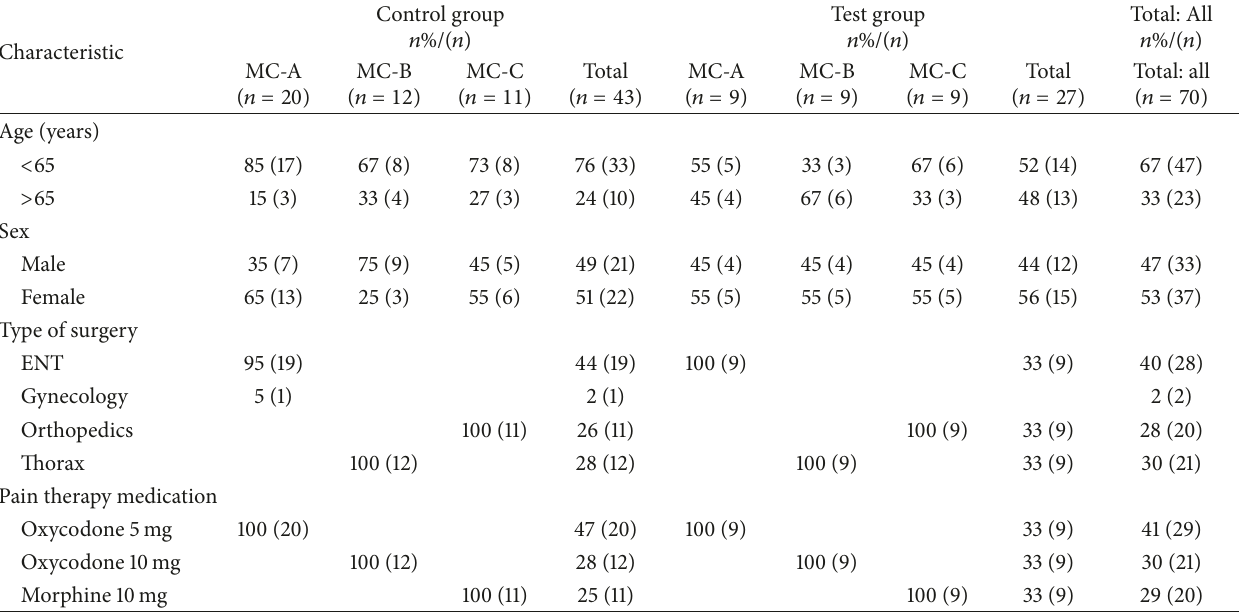
Table 1: Demographics and baseline characteristics of patients participating in the study (MC: Medical Center).